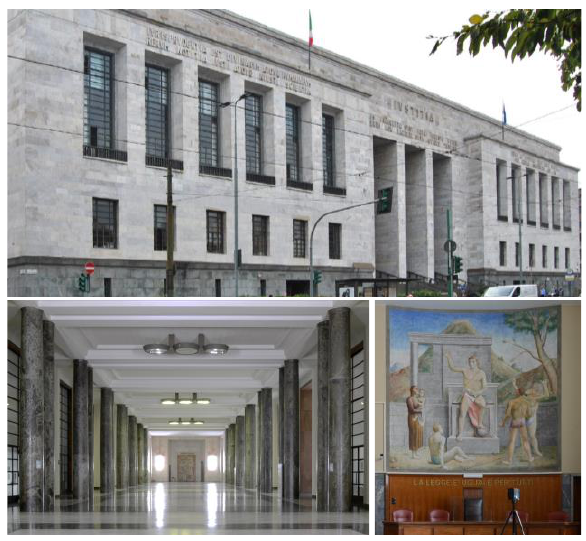
Figure 1. The Courthouse of